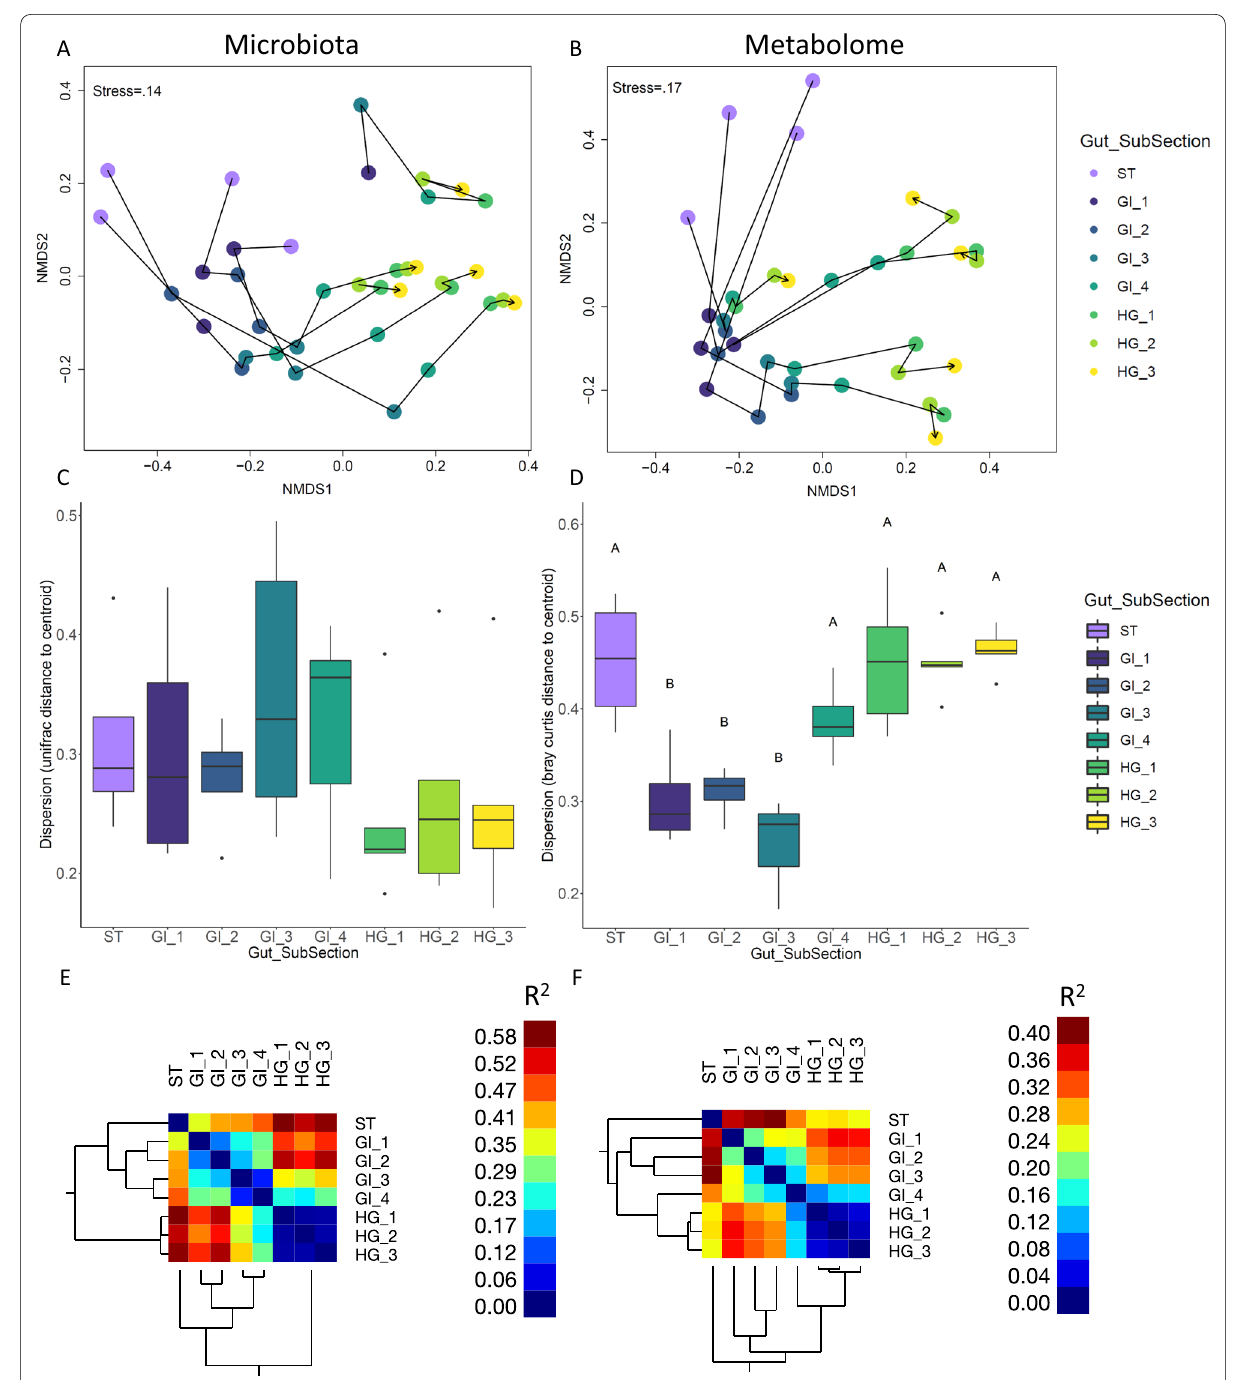
Fig. 2 Microbial ( A , C , E ) and metabolomic ( B , D , F ) multivariate analysis of nenue gut subsections. Non metric multidimensional scaling plots of the weighted unifrac distances among microbial communities ( A ) and bray Curtis distances among metabolomic samples ( B ) from the nenue gut. Samples are colored by gut subsection. Arrows track the transition of microbiota/metabolomes in an individual fish, starting in the stomach and ending in the hindgut. Box and whisker plots depict multivariate dispersion of microbial communities (unifrac distance to centroid) ( C ) and metabolomic samples (bray curtis distance to centroid) ( D ). Samples are color coded by gut subsection. Dispersion in both microbial communities and metabolomic samples responded significantly to gut subsection, but only metabolomic samples showed significant post hoc pairwise differences (α .05, Tukey Post Hoc test), which are indicated by letter significance indicators. Clustering heatmaps depict pairwise R 2 values = between samples from PERMANOVAs for ( E ) microbiota and ( F ) metabolome